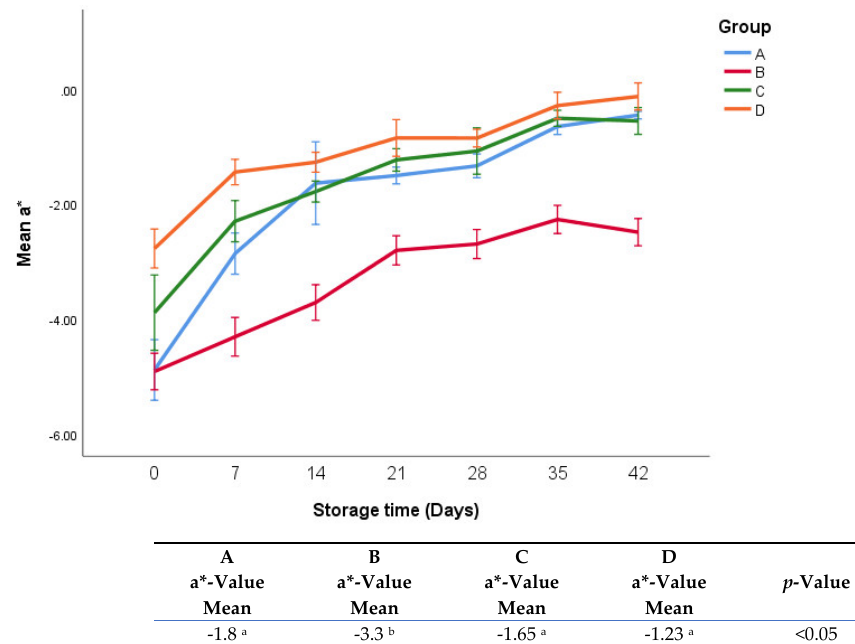
Figure 7. a*-values of fresh oregano at refrigerated temperature 4 °C during storage period (42 days). The significant differences ( p < 0.05) between means are indicated in different letters in the same row. The effect of treatments was pooled to consider the whole storage period and the means were separated by Duncan test. The effects of treatments on b*-values and L*-values are shown in Figures 8 and 9. It was found that there were no significant differences in b*-values between groups A, B, and C. Group D had significantly lower b*-values (9.9 vs. 12.1, 12.1, and 12.0, p < 0.05) than groups A, B, and C. It was observed that there was a sharp increase in b*-values in the first week in all groups.